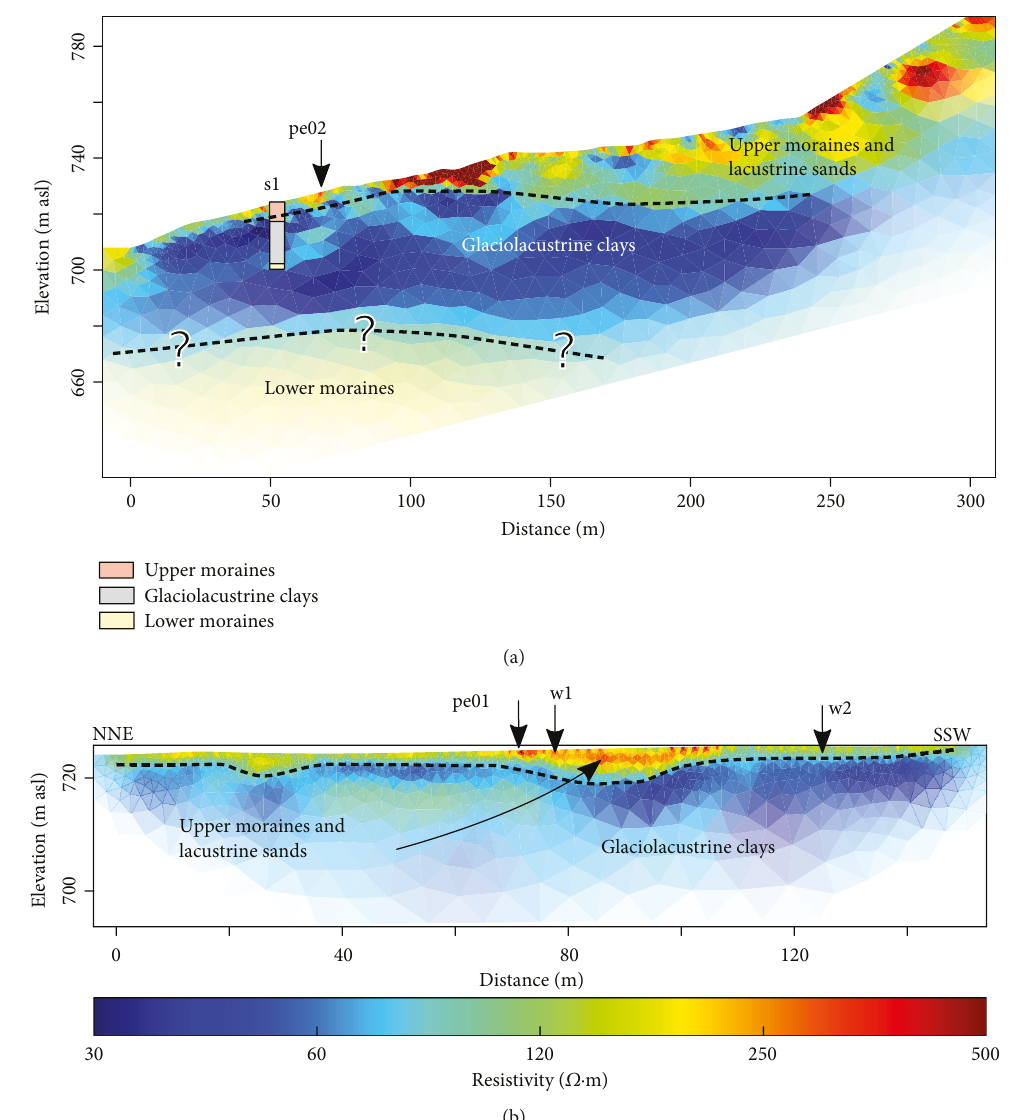
Figure 2: ERT pro fi les (a) pe01 and (b) pe02. Location is indicated in Figure 1. w1 and w2: water in fi ltration